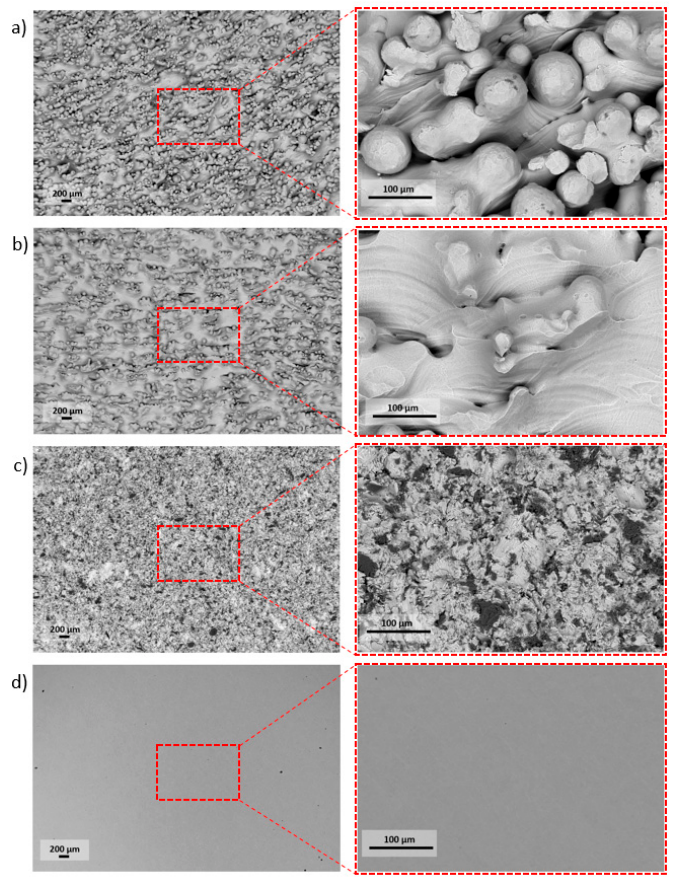
Figure 2. The high diversity of pellets’ surfaces followed by the specific type of surface treatment: ( a ) As-built, ( b ) acid-etched, ( c ) sandblasted, ( d ) machined.